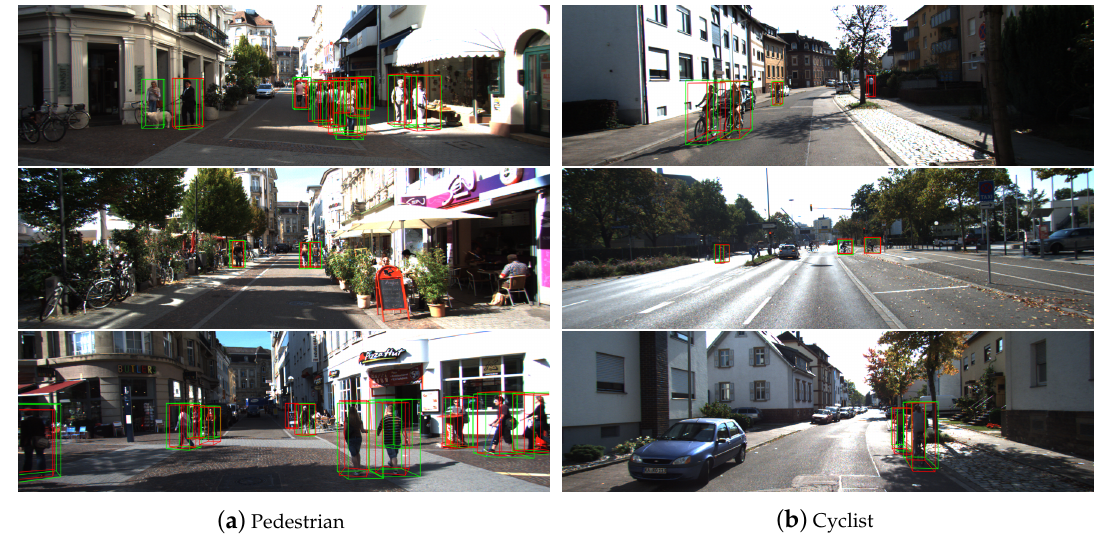
Figure 7. Results of 3D detection of Pedestrian and Cyclist on the KITTI validation set.